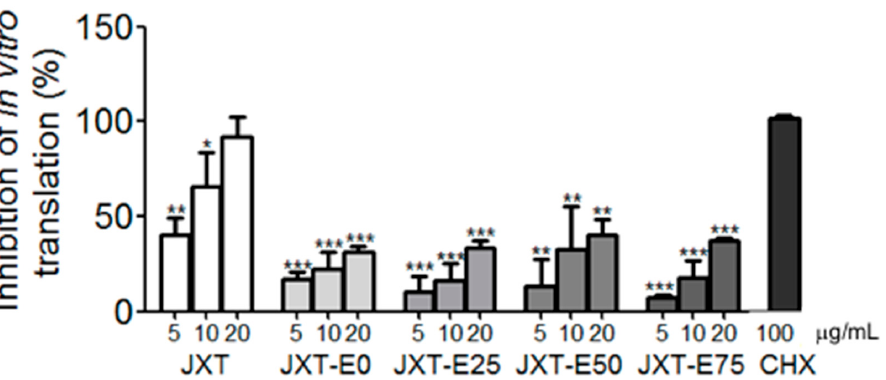
Figure 5. Effects of whole water and different ethanol extracts of JXT, and CHX on the translation of HCV RNA in a rabbit lysis cell-free lysate system. The results were obtained from three independent experiments and presented as mean ± SD (* p < 0.05, ** p < 0.01, *** p < 0.001 compared with DMSO control).